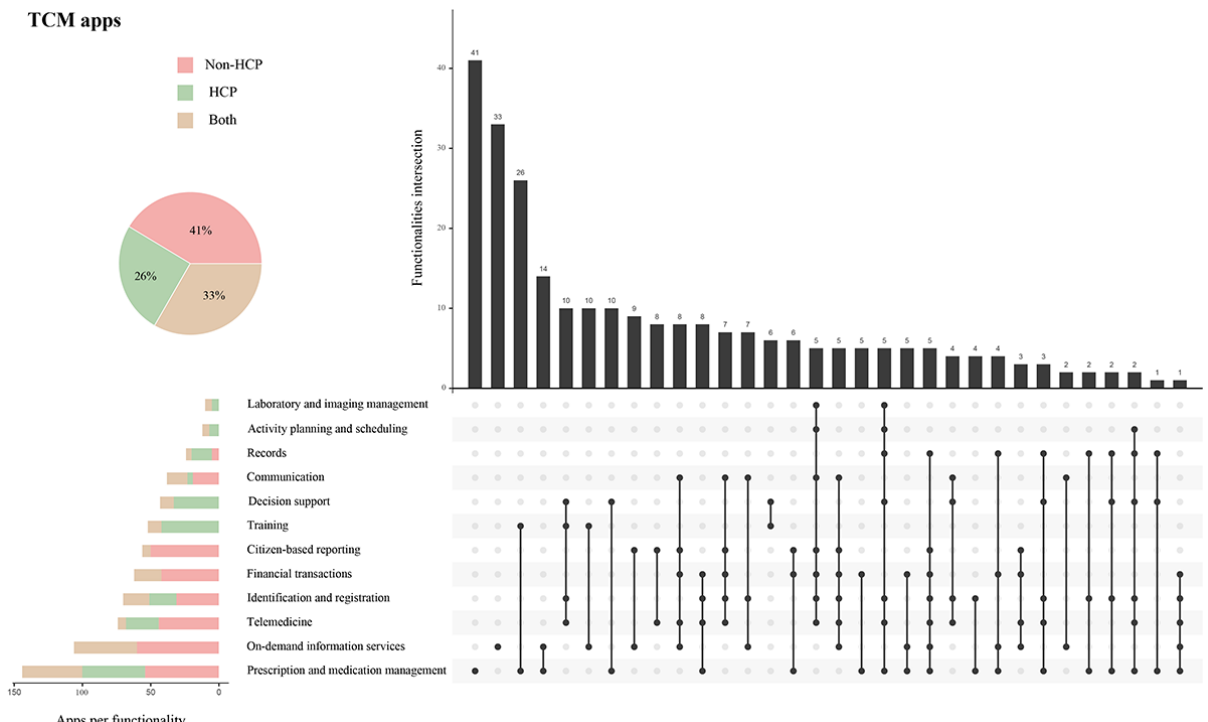
Figure 3. TCM apps’ functionalities. The pie chart shows the percentage of TCM apps’ target users. The stacked bar chart shows the distribution of TCM apps according to key functionalities and user type. The upset plot shows the intersection of multiple functionalities. TCM: traditional Chinese